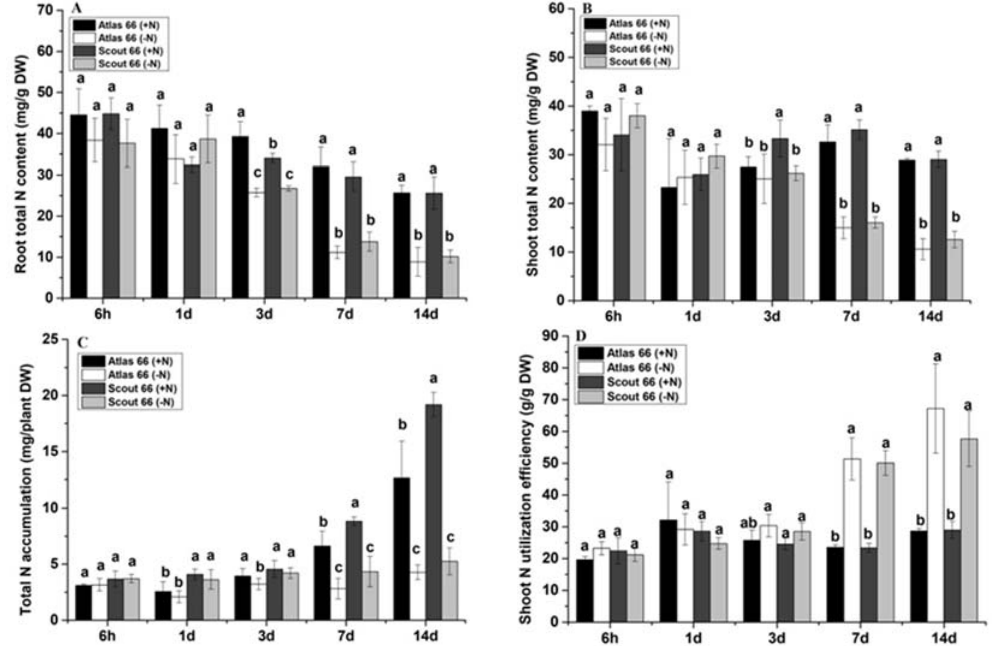
Figure 4. Effect of N deficiency on wheat plant root total N content ( A ), shoot total N content ( B ), total N accumulation ( C ), and shoot N utilization efficiency ( D ). Wheat plants were transferred from N sufficiency to either N sufficient (2 mM) or deficient (50 μ M) conditions for a defined treatment time, and the data presented here were sampled from a 6 h to 14 d time point from both N levels. Bars represent the mean ± SD ( n = 3). Different small letters indicate statistically significant differences based on LSD tests ( p ≤ 0.05) among the treatments and cultivars.